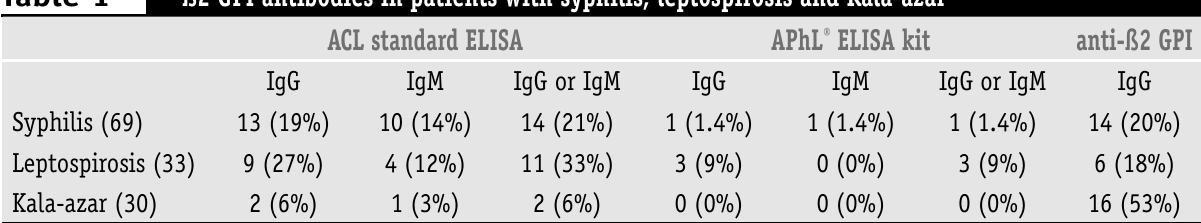
Specificity of three different antiphospholipid antibodies in ELISA methods ACL standard ELISA